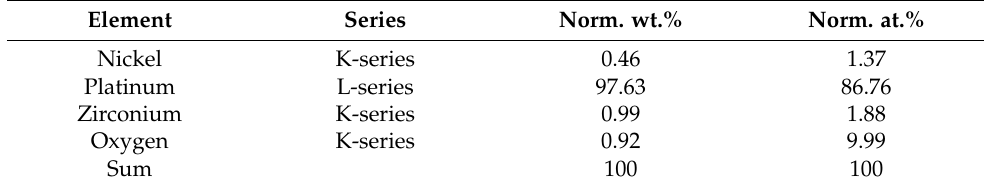
Table 3. Chemical composition of Pt agglomerate from Figure 8b (sample 5 ).